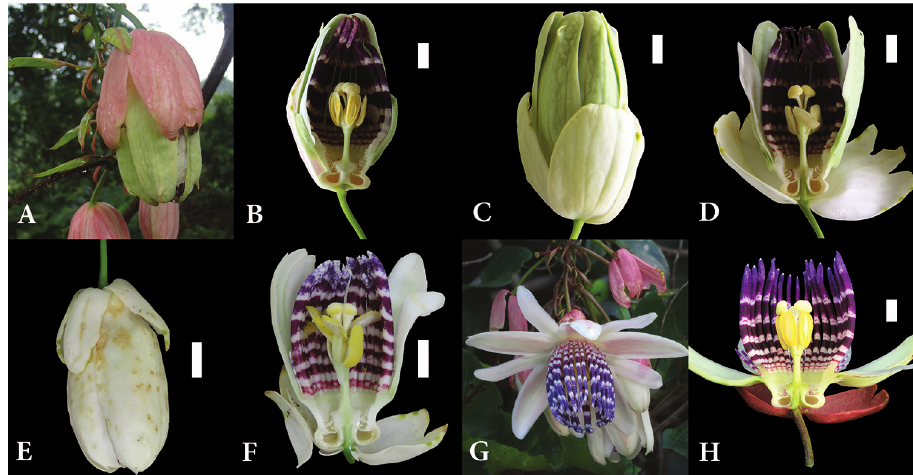
Figure 1. Comparison between flowers of P. riparia and P. crenata. A–C flowers of P. riparia from Alta Floresta, Mato Grosso, Brazil (photo: Rich Hoyer) D flower of P. riparia from Marituba, Para, Brazil (photo: Luis Otavio Adão Teixeiro) E–H flowers of P. crenata from Cacao village, French Guiana. Flower size is indicated by 1 cm white